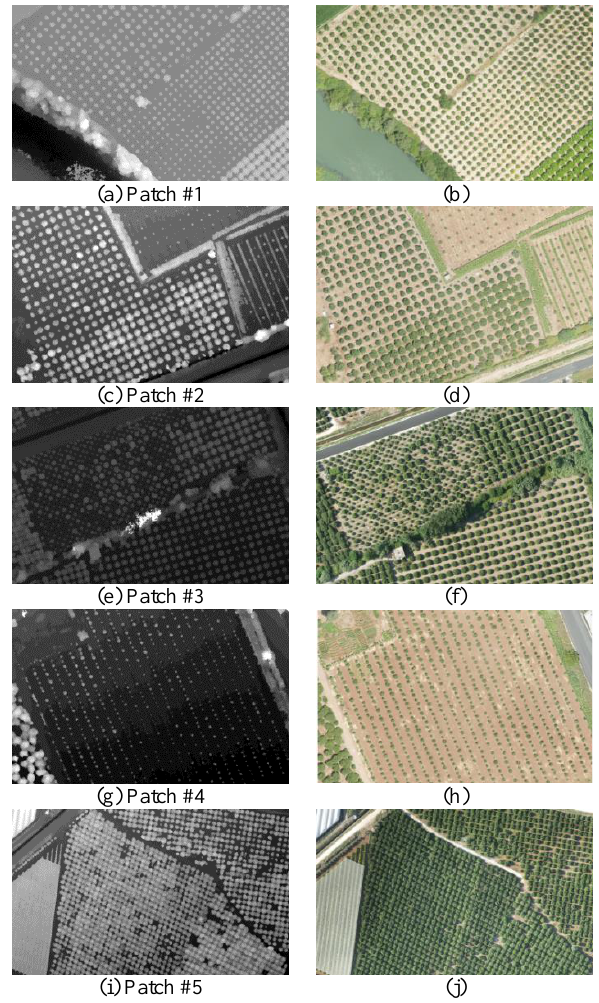
Figure 3. UAV dataset: DSM patches (#1-#5) are shown in (left column). Corresponding ortho-images (right column) are only presented for better visual understanding of the test patches.